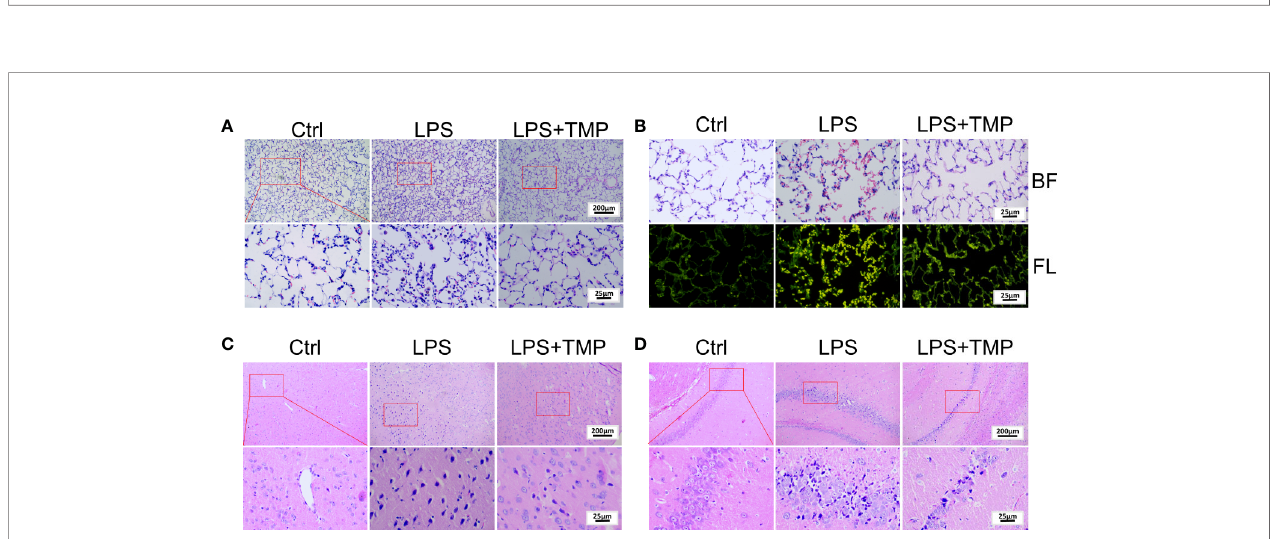
FIGURE 2 | Pathological observation of lung and brain tissue by HE staining. (A) Lung tissue (Upper, 100×; Lower, 400×). (B) Lung tissue observed under a fl uorescence microscope (400×). BF: Bright fi eld; FL: Fluorescence. (C) Cerebral cortex (Upper, 100×; Lower, 400×). (D) Hippocampus (Upper, 100×; Lower,